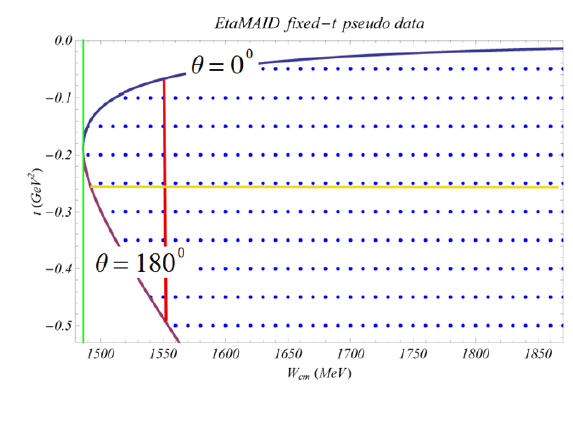
Figure 3: (Color online) Mandelstam (W,t) graph is shown for η -photoproduction.